Question: Looking at the figure, what chart type is it?
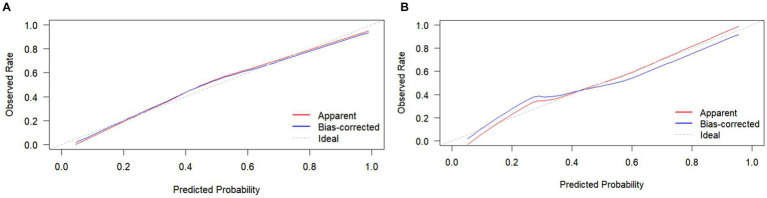
Answer: line